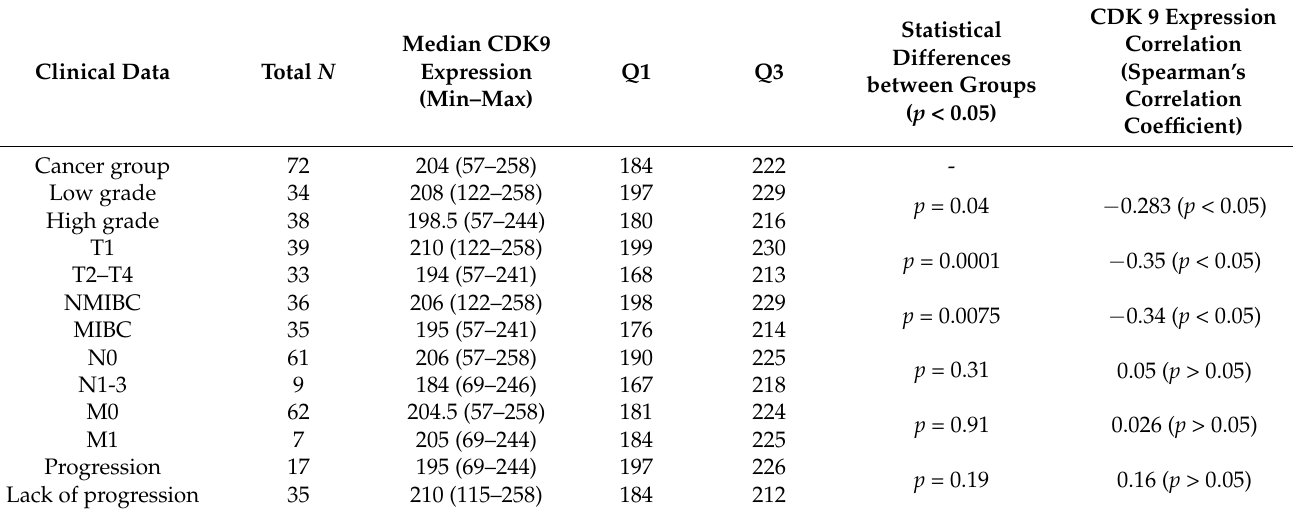
Table 2. Correlation between CDK9 expression and clinical predictors for bladder cancer.